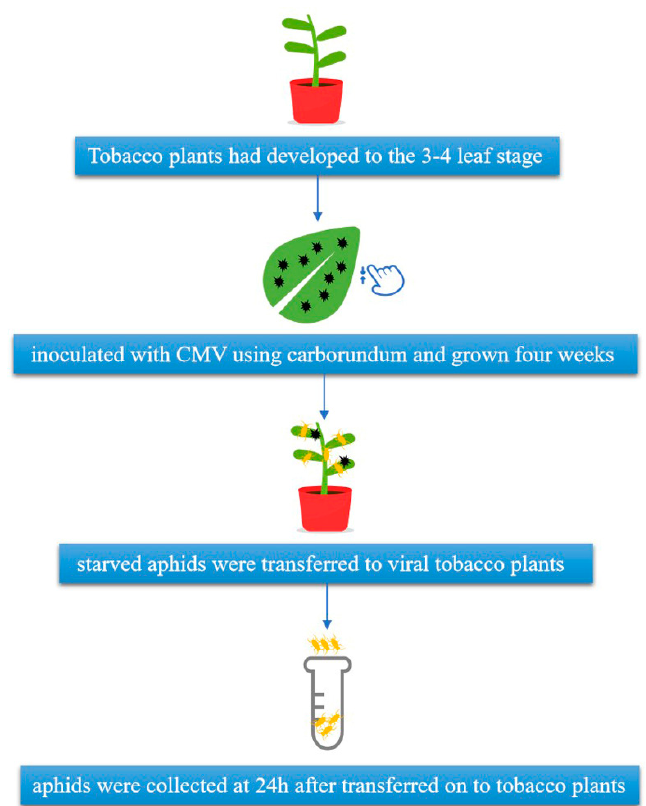
Figure 1. Workflow for sample collection.